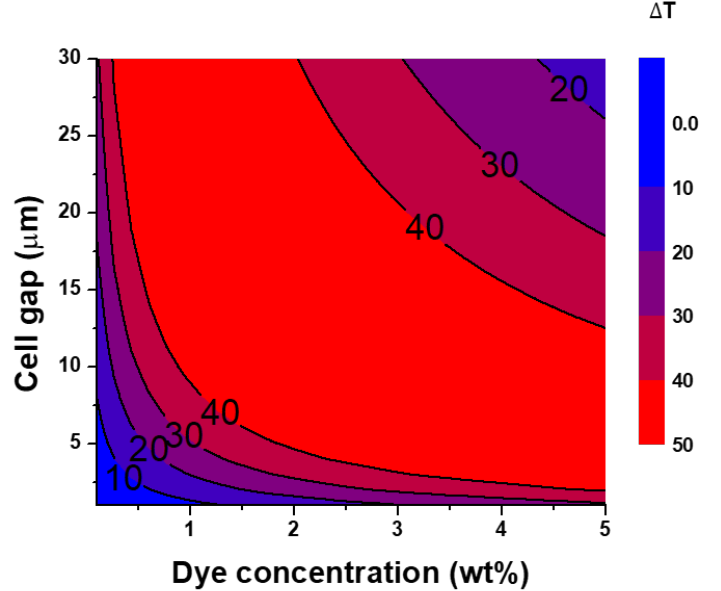
Figure 3. Calculated constant transmittance-difference contour map of a guest–host liquid crystal (GHLC) cell on the parameter space of the dye concentration and cell gap.